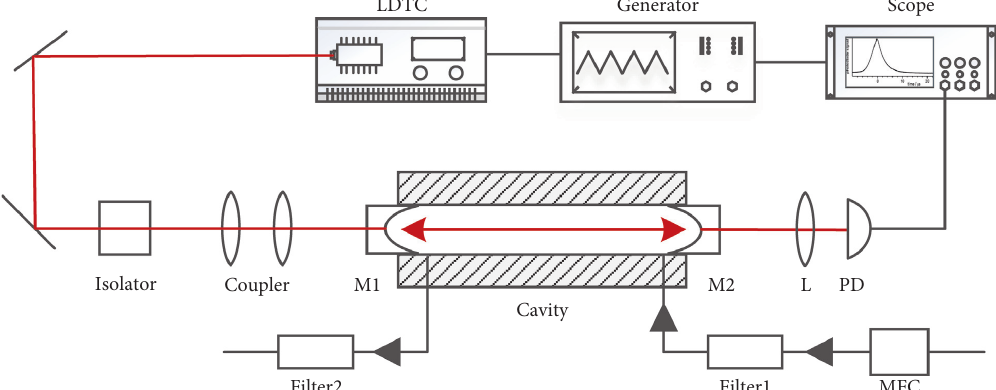
Figure 4: Schematic diagram of the experimental device. LDTC, laser driver and temperature controller. Generator, signal generator. M1 and M2, the RDC mirrors. RDC, ring-down cavity. L, focusing lens. PD, photodetector. MFC, mass flow